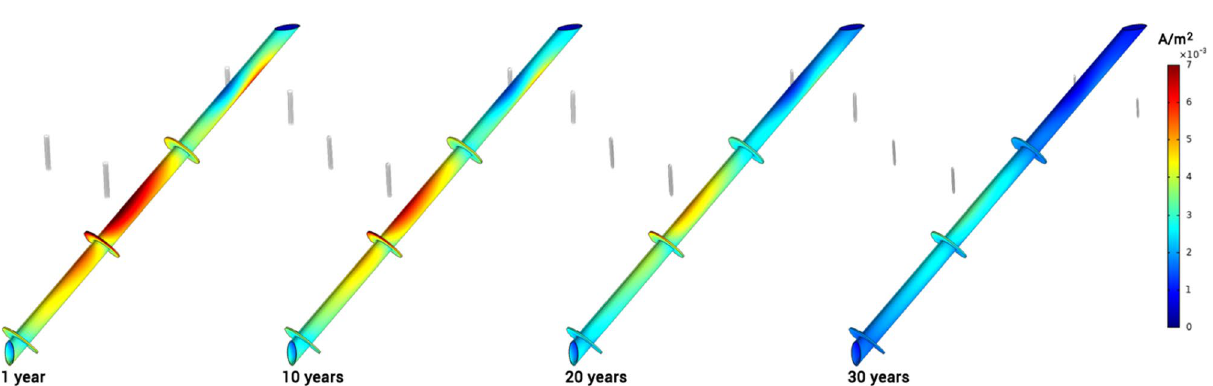
Figure 10. Variation of current density (A/m 2 ) distribution on the pile is shown for different years after CP system